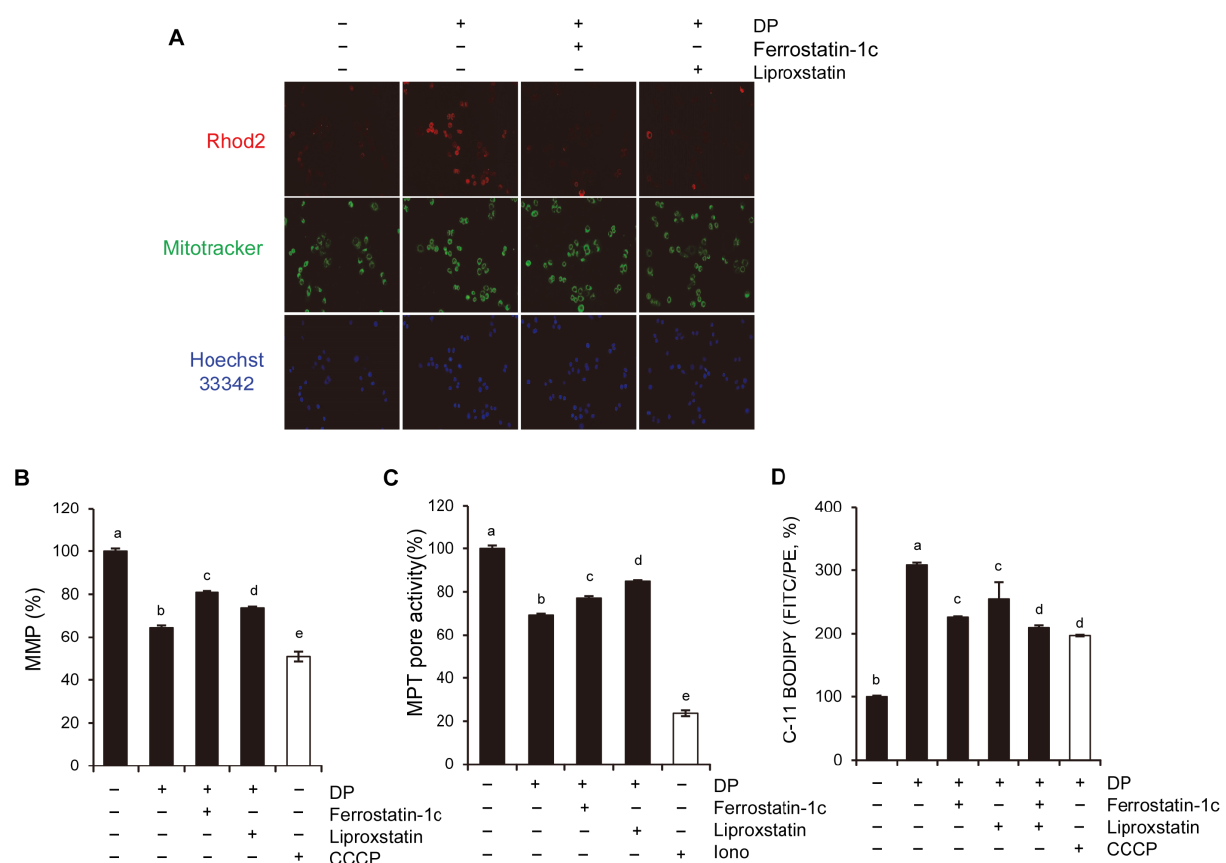
Figure 9. Ferroptosis is involved in DP-induced MPT-mediated cell death. ( A ) A549 cells were treated with 40 µM DP for 24 h with 1 h pretreatment with 5 µM ferrostatin-1 and 5 µM liproxstatin-1. The mitochondrial Ca 2+ level was detected by Rhod-2 (1 µg/mL) and MitoTracker green (200 nM). Images were acquired using a fluorescence microscope (magnification, 100 × , scale bar, 0.1